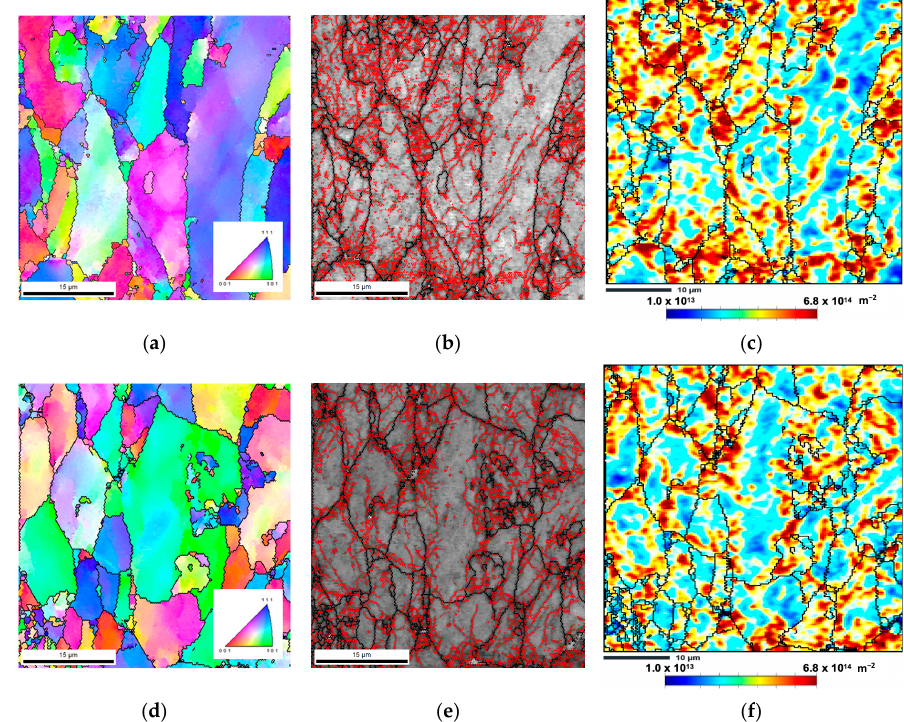
Figure 10. ( a , d ) Inverse pole figure (IPF) maps, ( b , e ) grain boundaries maps with LAGB delineated in red, and ( c , f ) estimated GNDs maps of Al and Al/CNT samples, cold rolled to 0.36. In the initial stages of cold rolling, the texture of the material may be relatively ran- dom or isotropic. However, as the material is plastic deformed, the crystal la tt ice begins to align along the rolling direction, developing a preferred orientation. The speci fi c texture evolution during cold rolling depends on various factors, including the initial crystallo- graphic texture of the material, the degree of deformation, the rolling direction, and the processing conditions. The texture evolution of the Al and Al/CNTs samples was